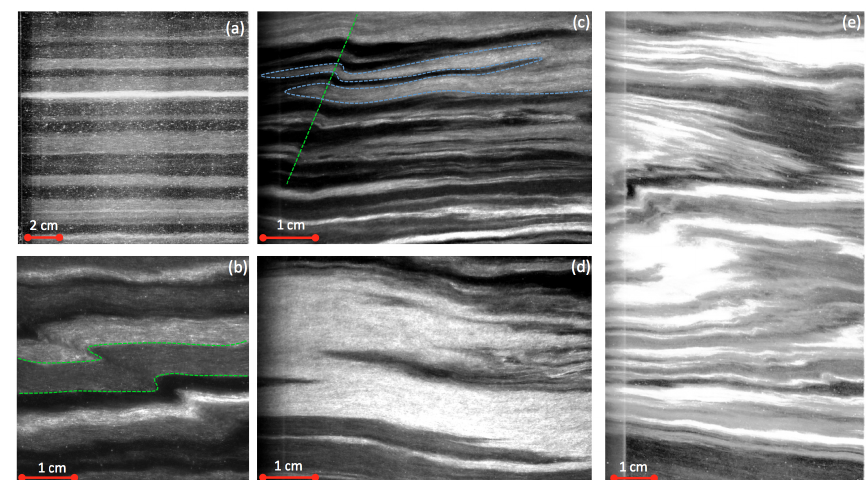
Figure 2. Close-ups from the overview Fig. 1. (a) Undisturbed layering. (b) Angular z fold consistent throughout layering. The green dashed line indicates a layer discussed in Sect. 3.1. (c) Different generation of folds. The dashed lines indicate features discussed in Sect. 3.1. (d) Strongly disturbed layer significantly thickened. (e) Strongly disturbed layering with different generations of